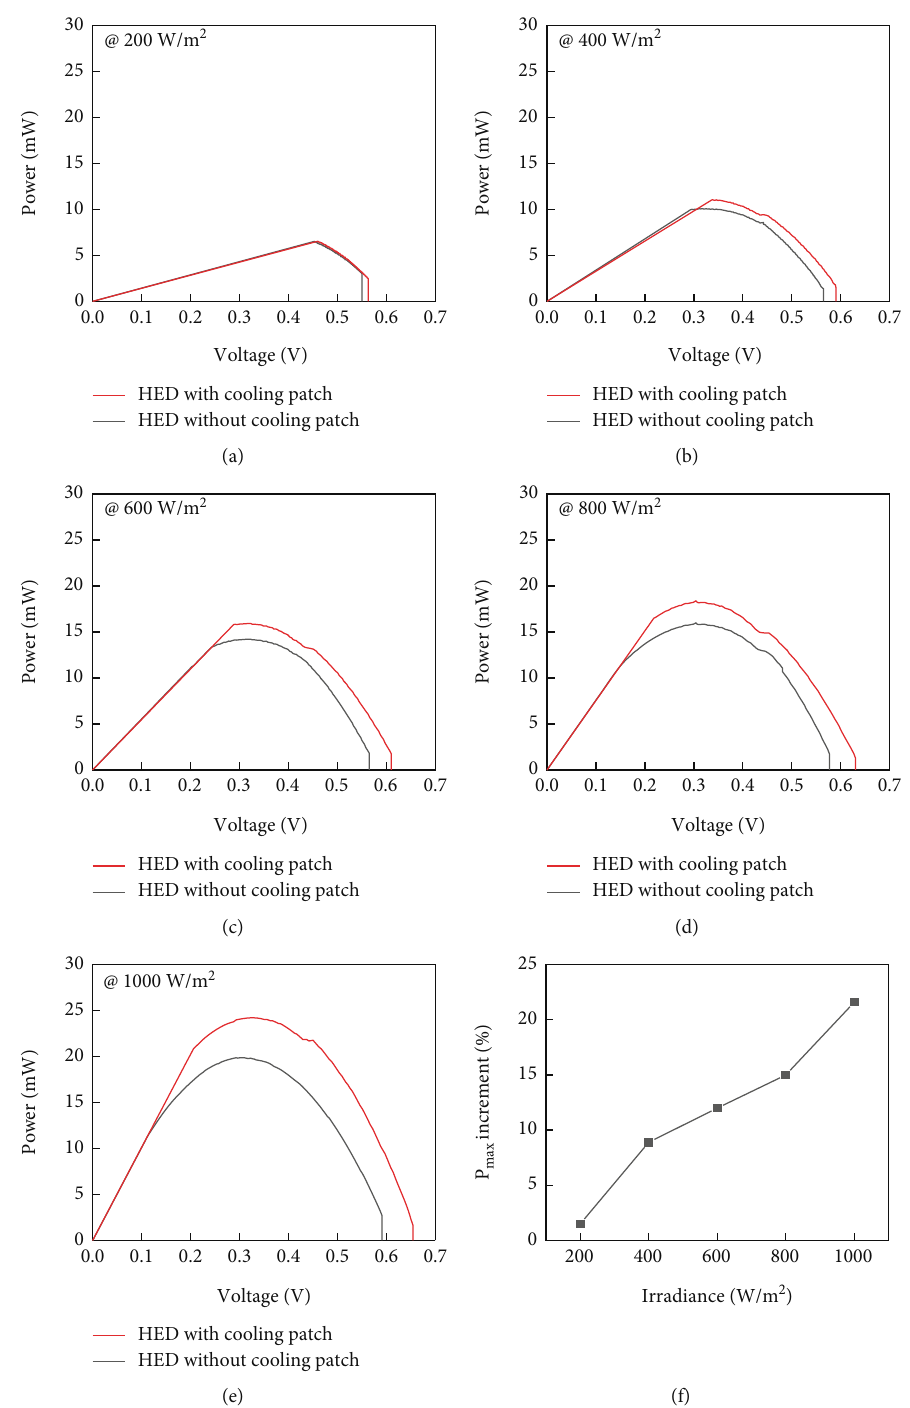
Figure 5: The output power curves of HEDs without and with the cooling patch at di ff erent irradiance levels: (a) 200W/m 2 , (b) 400 W/m 2 , increment of the HEDs with the cooling patch at irradiances in the range of 200 to (c) 600W/m 2 , (d) 800 W/m 2 , (e) 1000 W/m 2 , and (f) P max 1000W/m 2